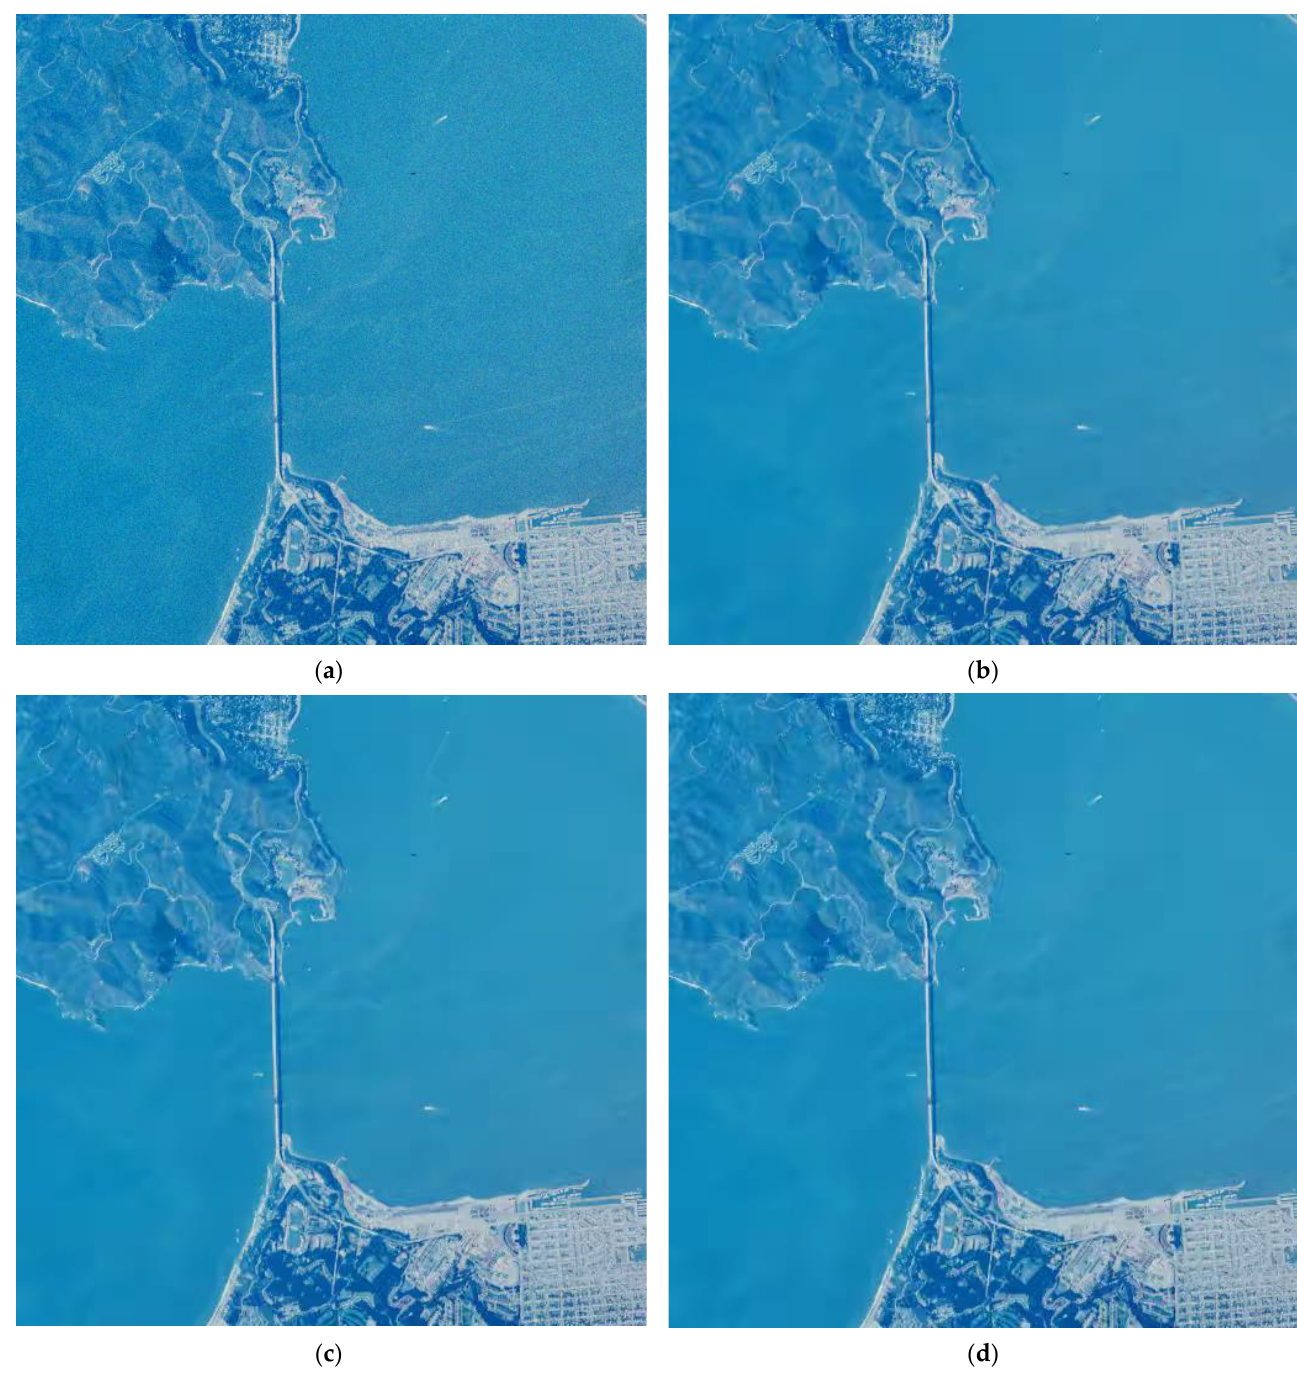
Figure 10. Original (noisy) image ( a ) and images compressed in OOP for the formats 4:4:4 (true ∆𝑃𝑆𝑁𝑅 − 𝐻𝐴 = 1.98, predicted ∆𝑃𝑆𝑁𝑅 − 𝐻𝐴 = 1.70, true ∆𝑀𝐷𝑆𝐼 = −0.038, predicted ∆𝑀𝐷𝑆𝐼 = −0.023) ( b ), 4:2:2 (true ∆𝑃𝑆𝑁𝑅 − 𝐻𝐴 = 2.09, predicted ∆𝑃𝑆𝑁𝑅 − 𝐻𝐴 = 1.91, true ∆𝑀𝐷𝑆𝐼 = −0.035, predicted ∆𝑀𝐷𝑆𝐼 = −0.024 ) ( c ), and 4:2:0 (true ∆𝑃𝑆𝑁𝑅 − 𝐻𝐴 = 1.98, predicted ∆𝑃𝑆𝑁𝑅 − 𝐻𝐴 = 1.80, true ∆𝑀𝐷𝑆𝐼 = −0.036, predicted ∆𝑀𝐷𝑆𝐼 = −0.023 ) ( d ); thus, compression in OOP is de-